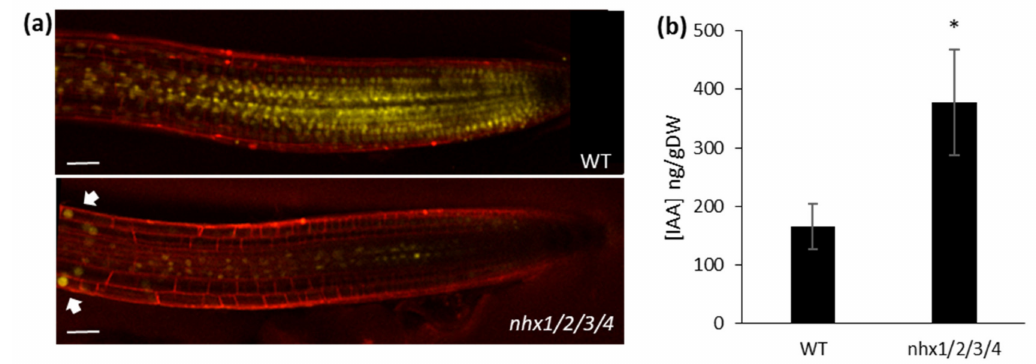
Figure 5. Root cells of nhx1nhx2nhx3nhx4 accumulate high levels of auxin. ( a ), DII-Venus expression in WT (upper) and nhx1nhx2nhx3nhx4 (nhx1 / 2 / 3 / 4) . nhx2nhx3nhx4 (nhx1 / 2 / 3 / 4) mutant grown under control conditions. Cells were labeled with propidium iodide (red) as a counter stain to show cell organization. Arrows indicate DII-Venus signals recovery in the elongation zone. Scale bar, 50 µ m. ( b ), Free-IAA content measured from the whole root of WT and nhx1nhx2nhx3nhx4 . Values are the Mean ± SD (n = 3). Star indicates statistical significance ( P < 0.05 by t